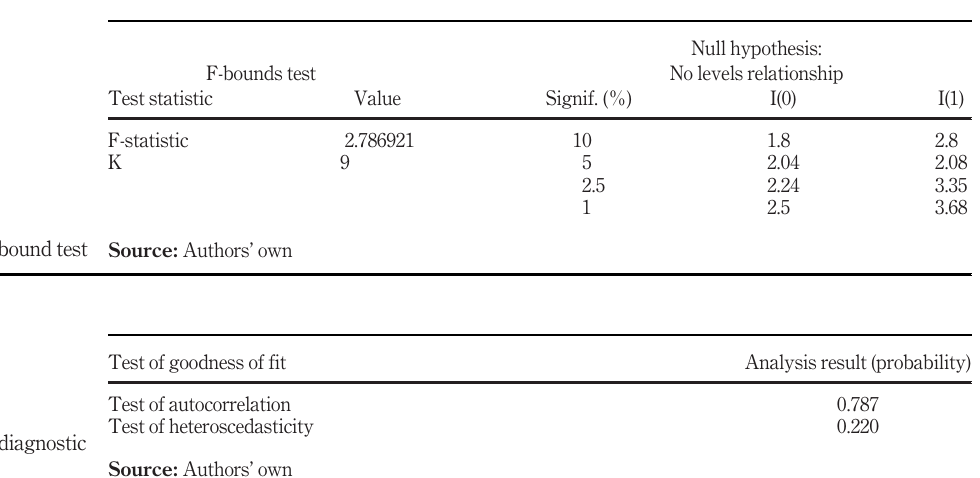
Table 6. Results of